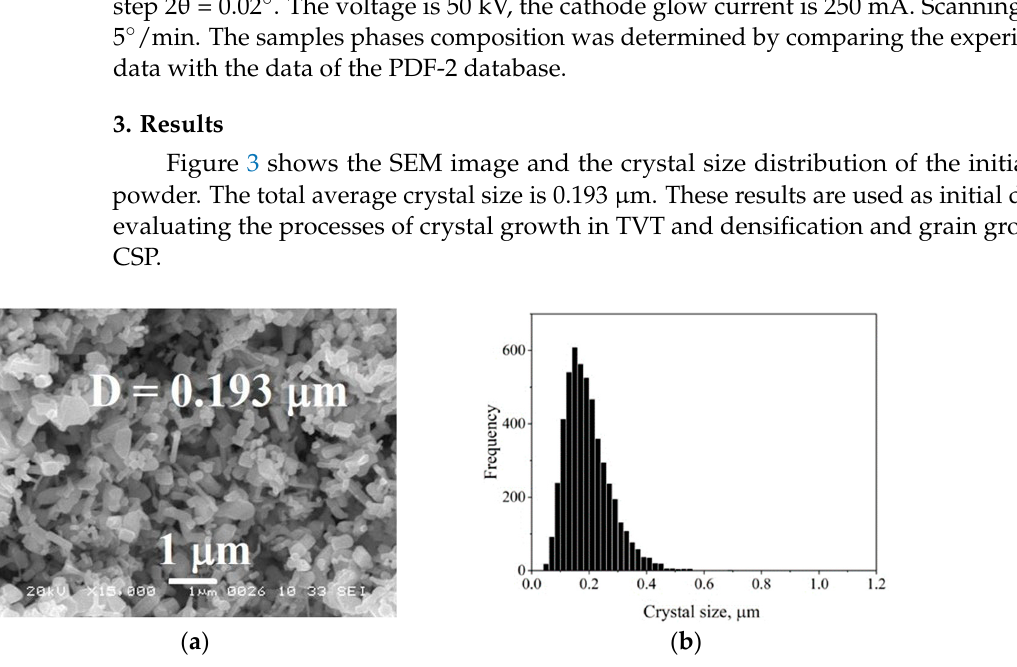
copyright (2019), with the kind permission of Springer Nature.); ( b ) crystal size distribution. the kind permission of Springer Nature.); ( b ) crystal size